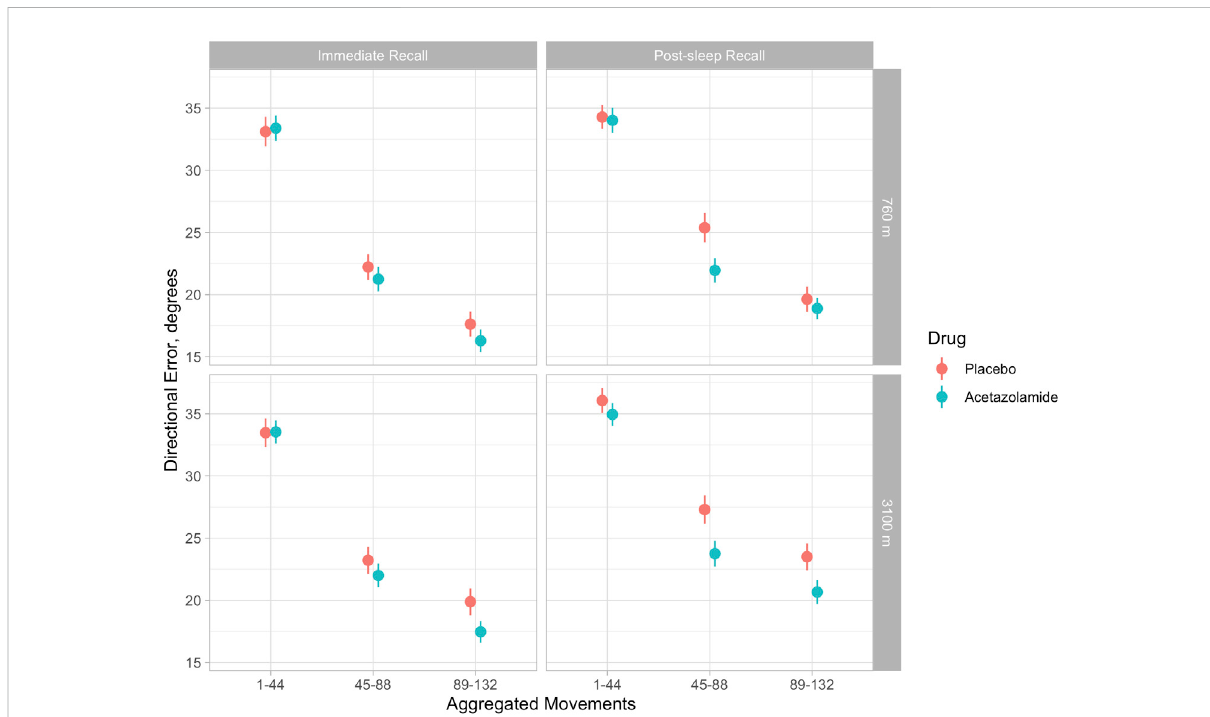
FIGURE 3 Illustration of means (and 95% con fi dence intervals) of directional errors for the acetazolamide (blue) and placebo (orange) group in 3 successive blocks of 44 movements each during immediate (evening) and post-sleep (morning) recall tests. Upper panels: baseline evaluations at 760 m were performed before starting the study drug. Upper left panel: immediate recall at 760 m; upper right panel, post-sleep recall at 760 m; lowerleftpanel,immediate recallat3100 m;lowerrightpanel,post-sleeprecallat3100 m.AccordingtoTable 2,intestsat3100 m,directional errors were signi fi cantly reduced by acetazolamide during immediate recall (by 2.7 ° , 95% CI 1.6 – 3.7) and post-sleep recall by 3.1 ° , 95% CI 2.0 – 4.3). The progressive decrease in directional error with increasing number of the 132 blocks is consistent with a learning effect, while the last block of aggregated movements (89 – 132) is a surrogate of fi nal performance